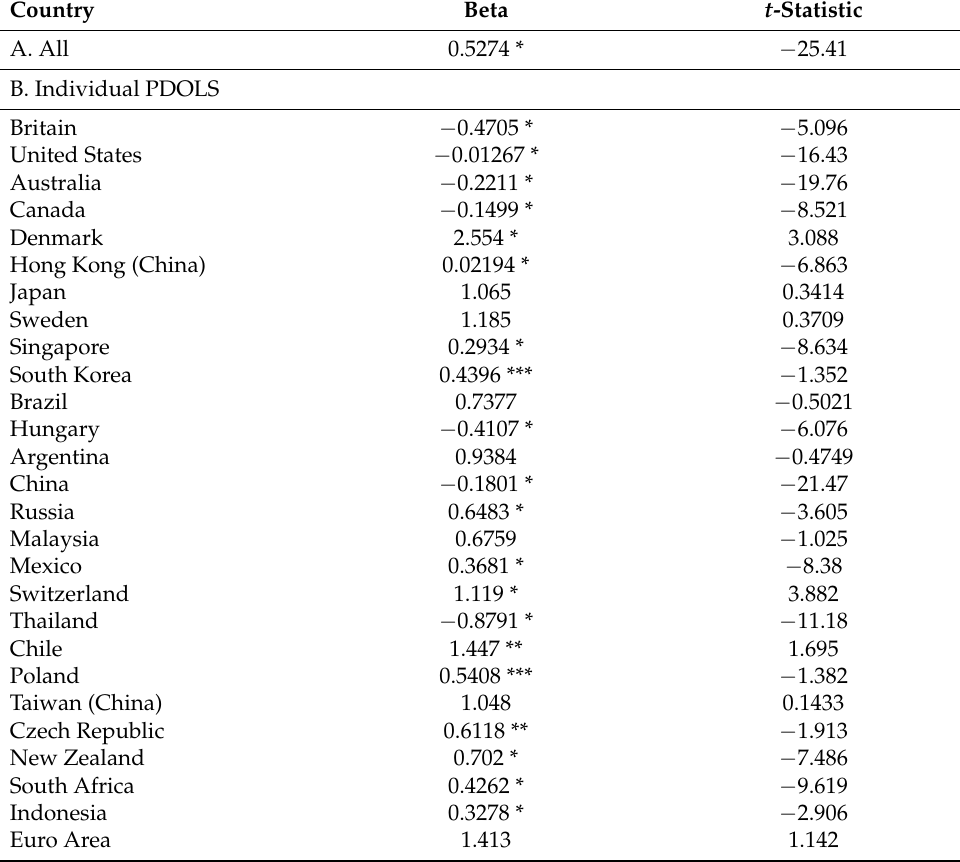
Table 4. Pedroni’s